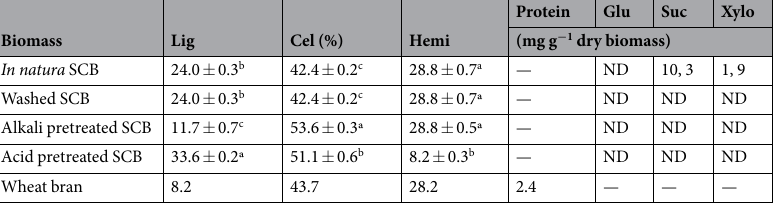
Table 1. Chemical composition of sugarcane bagasse (SCB) samples in comparison to chemical of wheat bran 46 . Lig: Lignin; Cel: cellulose; Hemi: hemicellulose; Glu: glucose; Suc: sucrose; Xylo: xylose. Averages followed by the same letter do not differ by the Tukey test at 5%